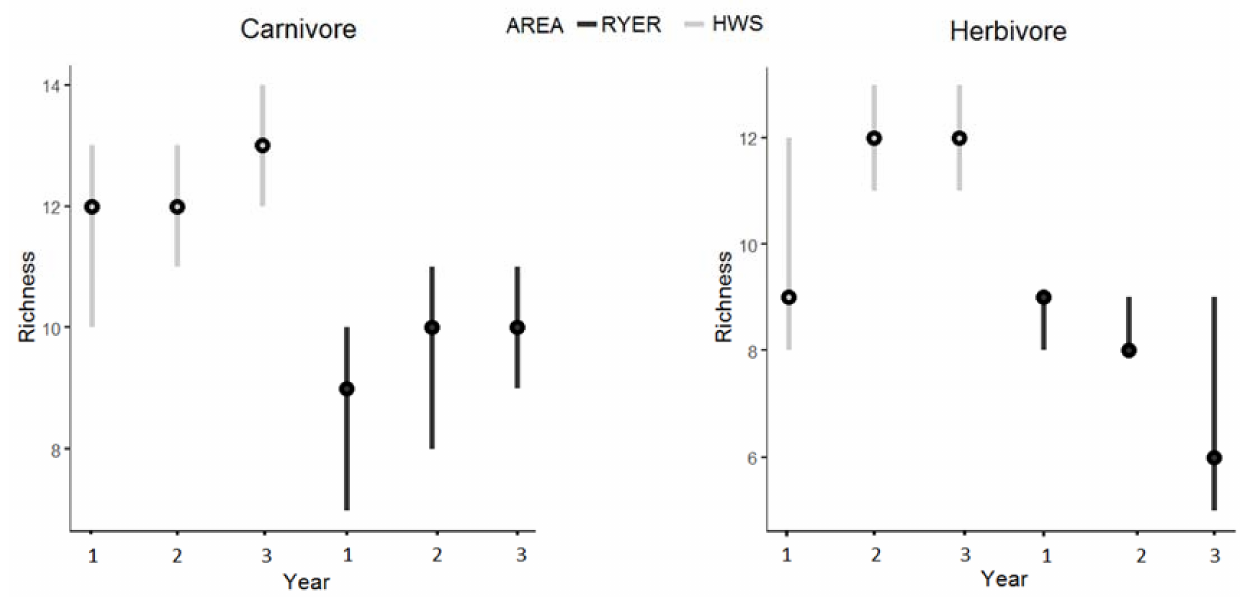
Figure 3. Estimated species richness during the 3 years of monitoring in both areas (Htamanthi Wildlife Sanctuary (HWS): light grey; Rakhine Yoma Elephant Range (RYER): black) with median (black dots) and 95% Bayesian credible intervals for the two significantly different groups of carnivore and herbivore. Table 2. Estimated species richness (median and 95% Bayesian credible intervals) for the three considered trophic niches groups (herbivore, carnivore, and omnivore) in the two areas (Htamanthi Wildlife Sanctuary (HWS) and Rakhine Yoma Elephant Range (RYER)) during the three years (y1, y2, and y3). “tot” indicates the total estimated species richness.